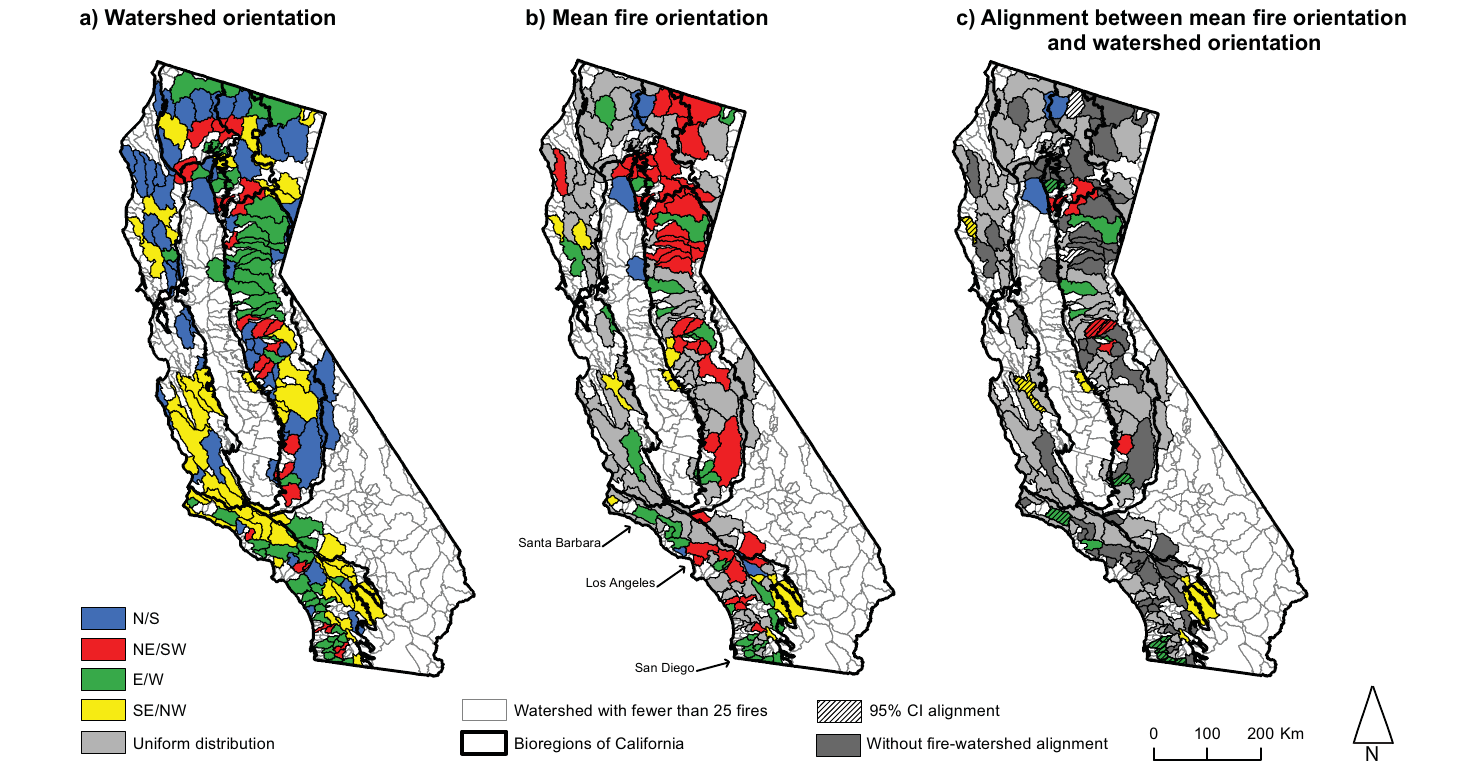
Figure 5. The left map ( a ) represents watershed orientation using the sub-unit level of the CalWater watershed map. The center map ( b ) presents results of fire perimeter orientation analysis for each watershed. Watersheds with preferential fire orientation are color-coded according to the compass classification of mean fire orientation, and watersheds where fire orientations are random are shown in gray. The right map ( c ) presents watersheds with evidence of orographic channeling of fires. Watersheds represented in black-striped pattern have their orientation contained within the 95% confidence interval of mean fire orientation. Alternatively, watersheds that share the same compass orientation as fires are color-coded accordingly. Watersheds that are both color-coded and black-striped depict evidence of orographic channeling of fires according to both criteria. Watersheds mapped as dark gray show no alignment between mean fire and watershed